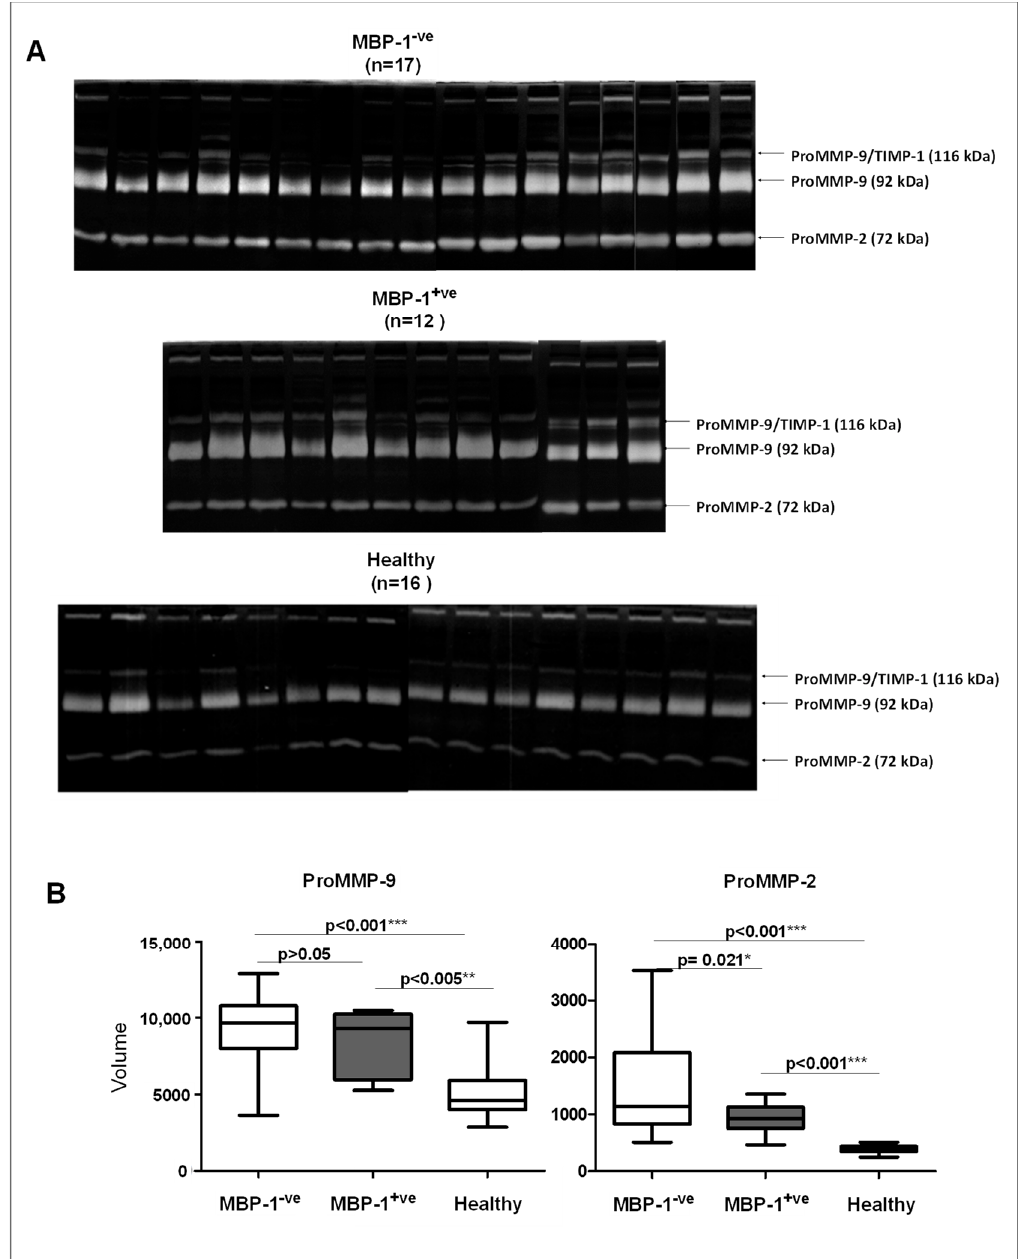
Figure 5. ProMMP-9 and ProMMP-2 activity levels in breast cancer sera according to MBP-1 expression and healthy subjects. ( A ) Gelatin zymography of sera of MBP-1 -ve , MBP-1 +ve breast cancer patients and healthy subjects; ( B ) quantification of lytic bands. Each data point is the average of three independent experiments. Error bars represent standard deviation and p values indicate statistical significance.